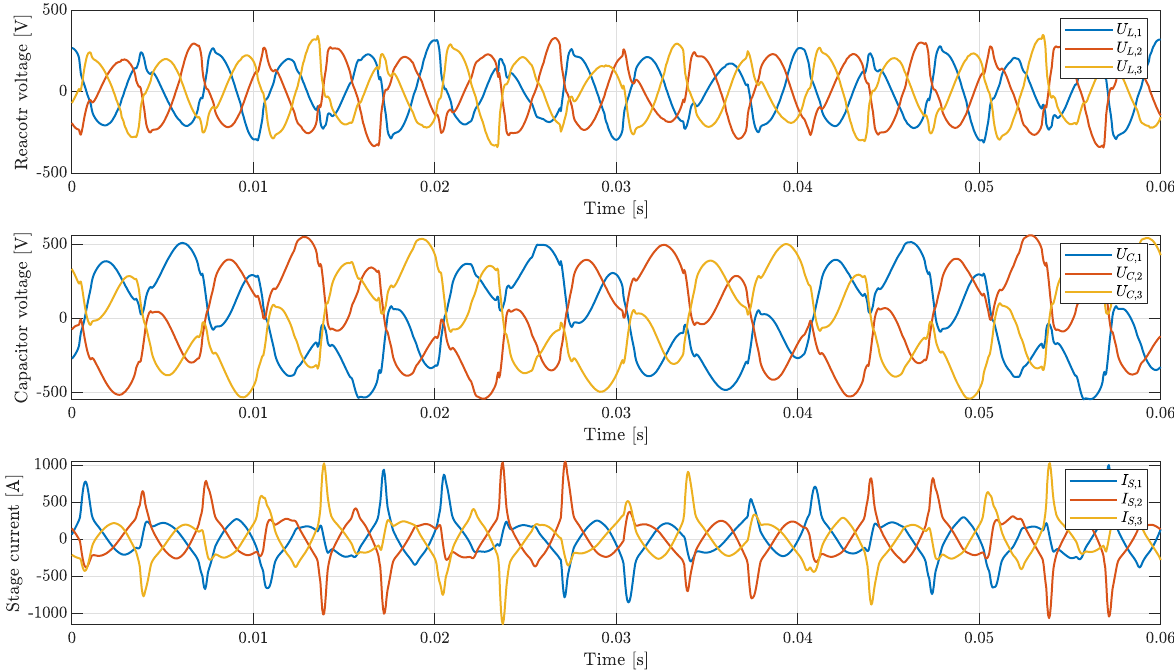
Figure 17. C2—Capacitor voltage, reactor voltage and stage current after the stage is switched on.